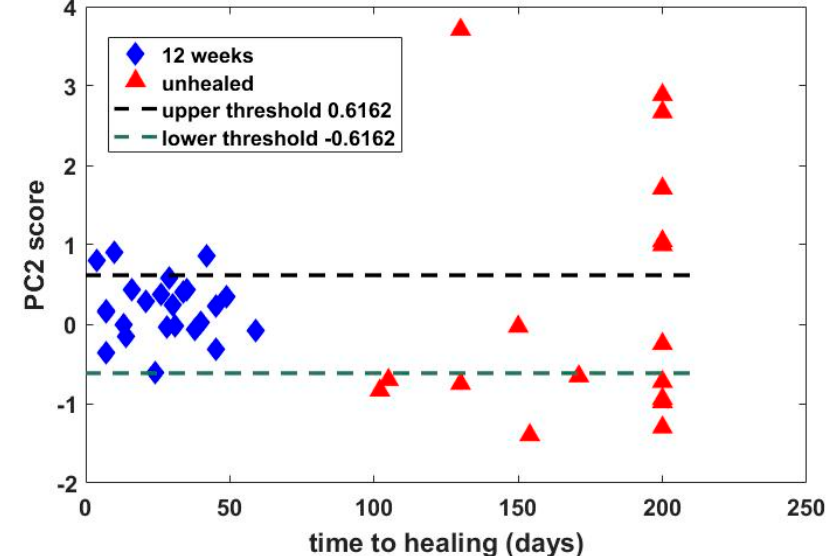
Figure 4. Relationship between time to healing (days) and principal component 2 (PC2). In order to plot unhealed ulcers, healing days was set at 200 (higher than all the healing days of the healed ulcers).